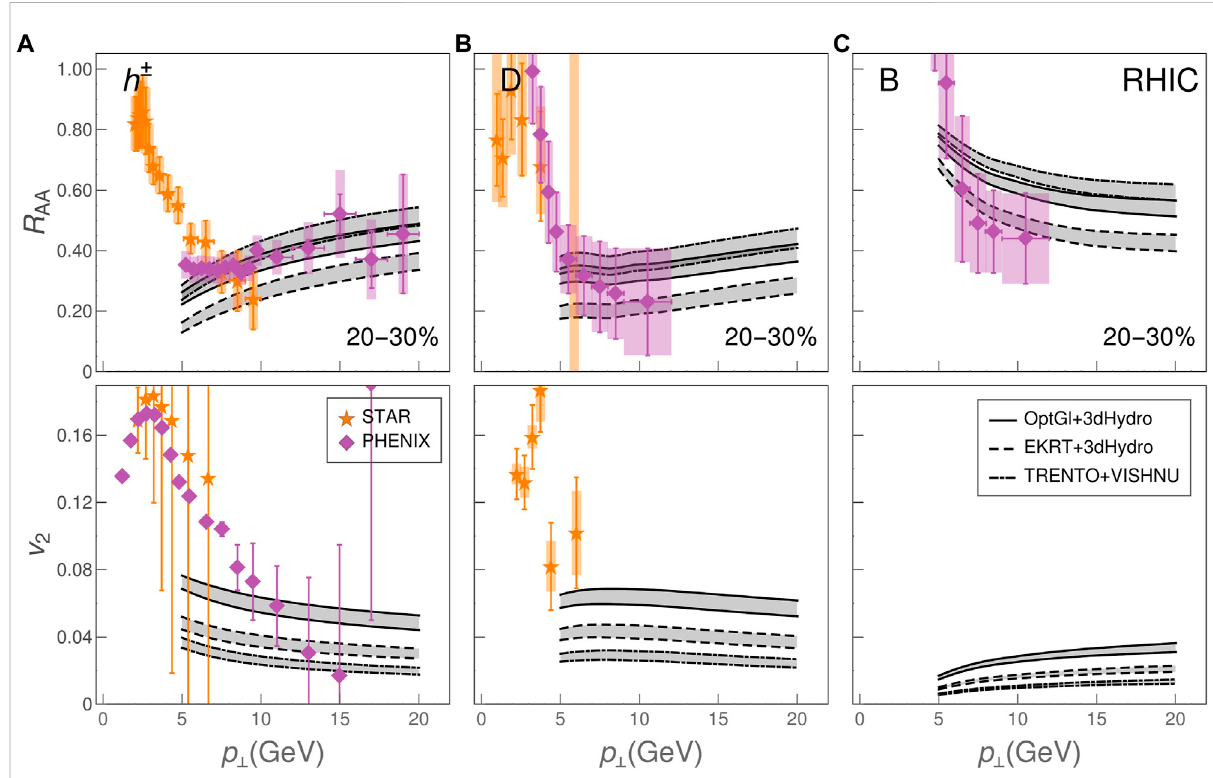
FIGURE 7 DREENA-A R AA (top panels) and v 2 (bottom panels) predictions in Au + Au collisions at QGPmediumevolution(indicatedinthelegend).Chargedhadron (A) ,Dmeson (B) andBmeson (C) predictionsaregeneratedfor20 – 30%centrality region. The h ± predictions are compared with π 0 data from PHENIX [99, 100] and h ± data from STAR [101, 102] - note that for v 2 10 – 40% centrality dataisshownforSTAR.ForDmesons, thepredictionsarecomparedwithSTAR[103,104]dataat10 –